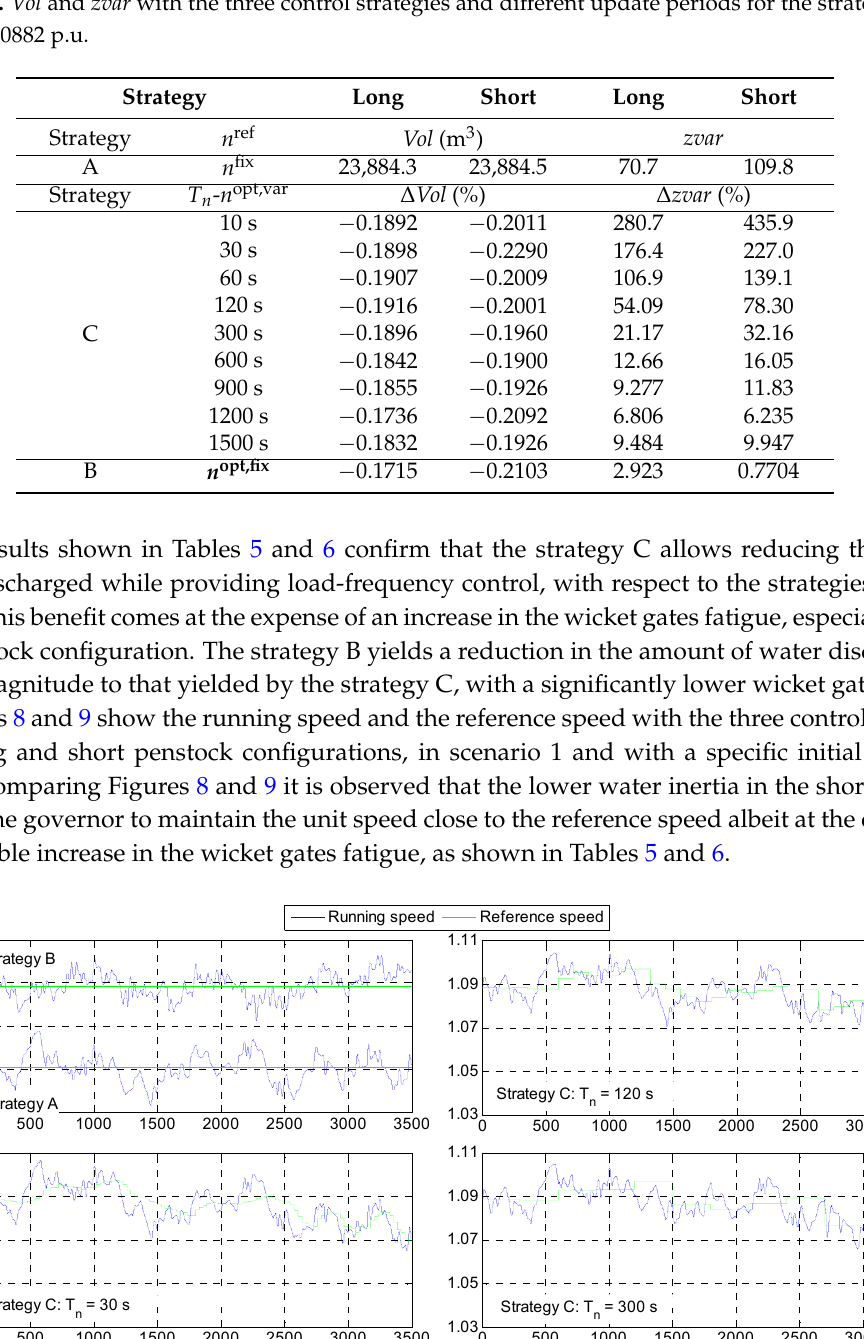
Figure 9. Running speed and reference speed with the three strategies. Short penstock configuration, p 0 = 0.7 p.u., h c0 = 1.131 p.u., scenario 1. 6.2. Initial Power Tables 7 and 8 show the results obtained with the three control strategies for different initial powers delivered to the system by the PSHP. The results corresponding to the strategy A are used as a basis for the comparison. The results included in the Tables are the average values across the three initial considered gross heads. The update periods which give the least Vol and the least zvar in Tables 5 and 6 have been used for the strategy C in this case. On the one hand, the results shown in Tables 7 and 8 confirm those discussed in Section 6.1: the strategy B yields a reduction in the amount of water discharged similar to that yielded by the strategy C, with a considerable reduction in the wicket gates fatigue. On the other hand, the results shown in these tables demonstrate that the water savings yielded by the strategies B and C slightly decrease as